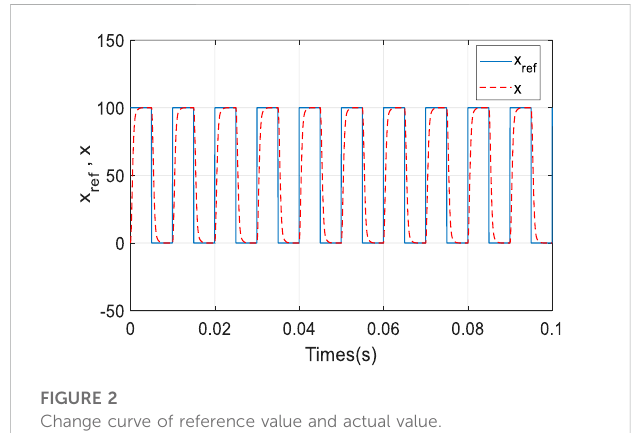
FIGURE 2 Change curve of reference value and actual value.